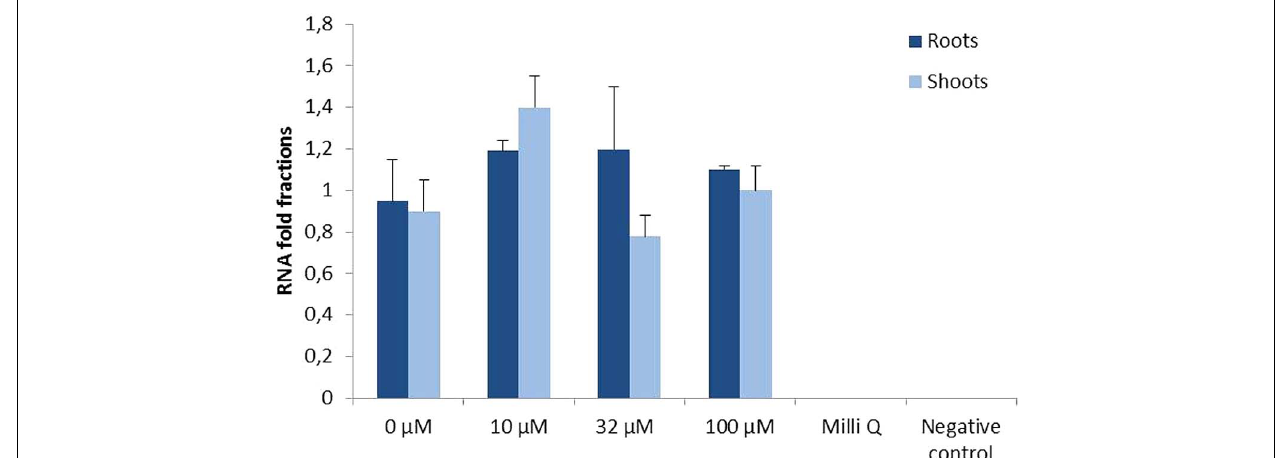
FIGURE 4 | Relative AtFRO2 RNA expression in roots and shoots of transgenic 392-3 soybean plants supplied with 0, 10, 32, or 100 μ M Fe(III) EDDHA detected by Quantitative RT-PCR (Biorad). Amount of transcript